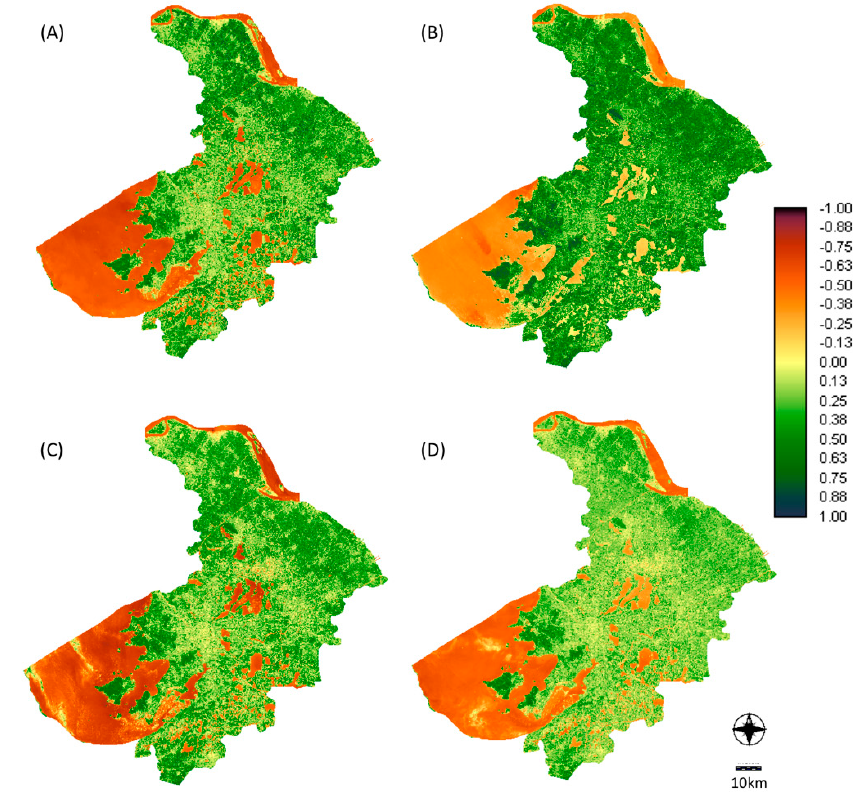
Figure 1. Distribution of NDVI in Suzhou, China 2014: ( A ) 16 March; ( B ) 22 June; ( C ) 26 October; ( D ) 29 December. Table 3. Odds ratios of association between respiratory and allergic outcomes and NDVI IQR in different buffer areas. a